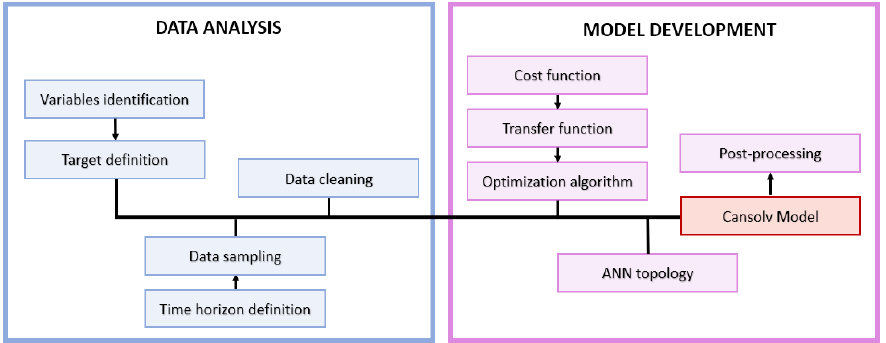
Figure 2. Scheme of the methodology employed to develop the Calsolv ® model. Firstly, the data were analyzed, sampled, and cleaned. Then, after tuning the different hyperparameters, the model was developed and the results were validated.